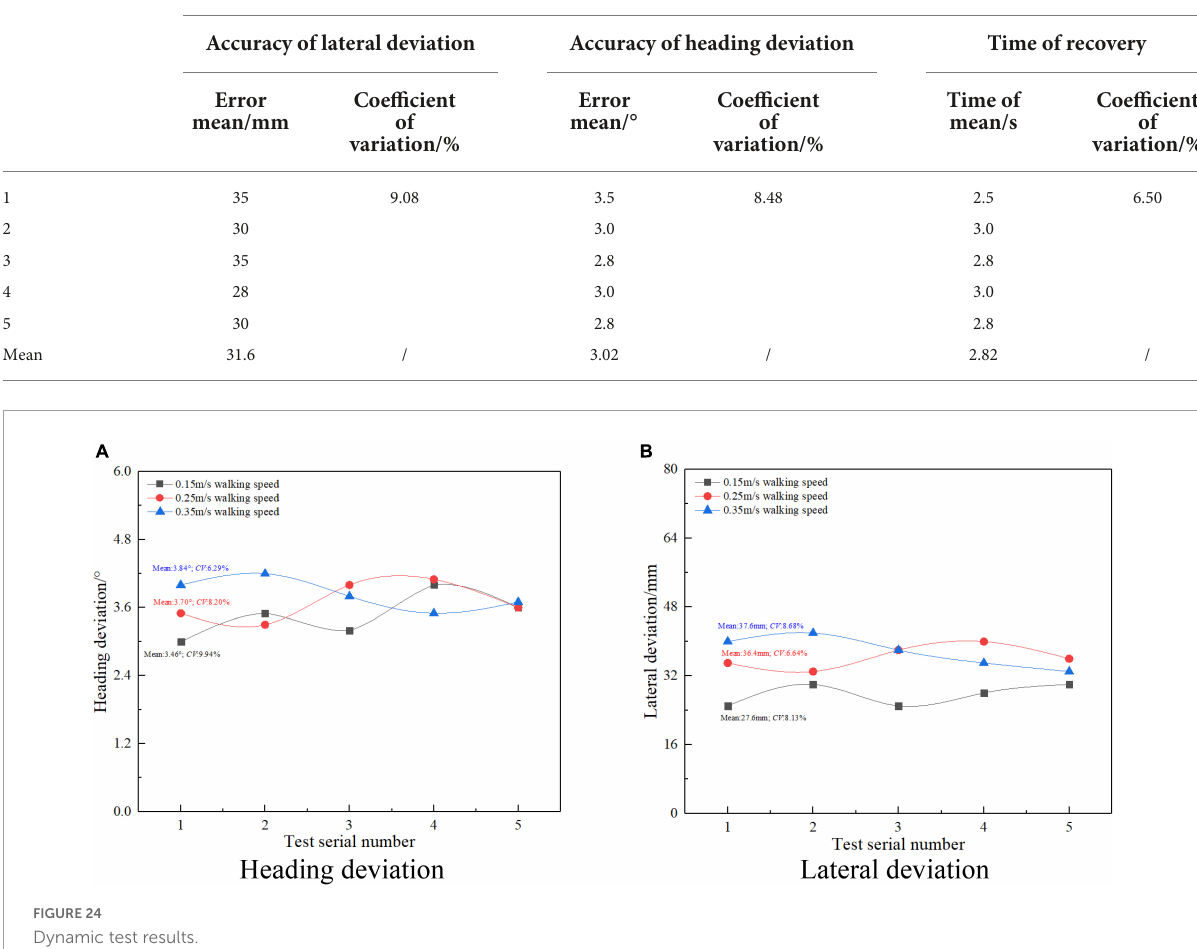
FIGURE24 Dynamic test